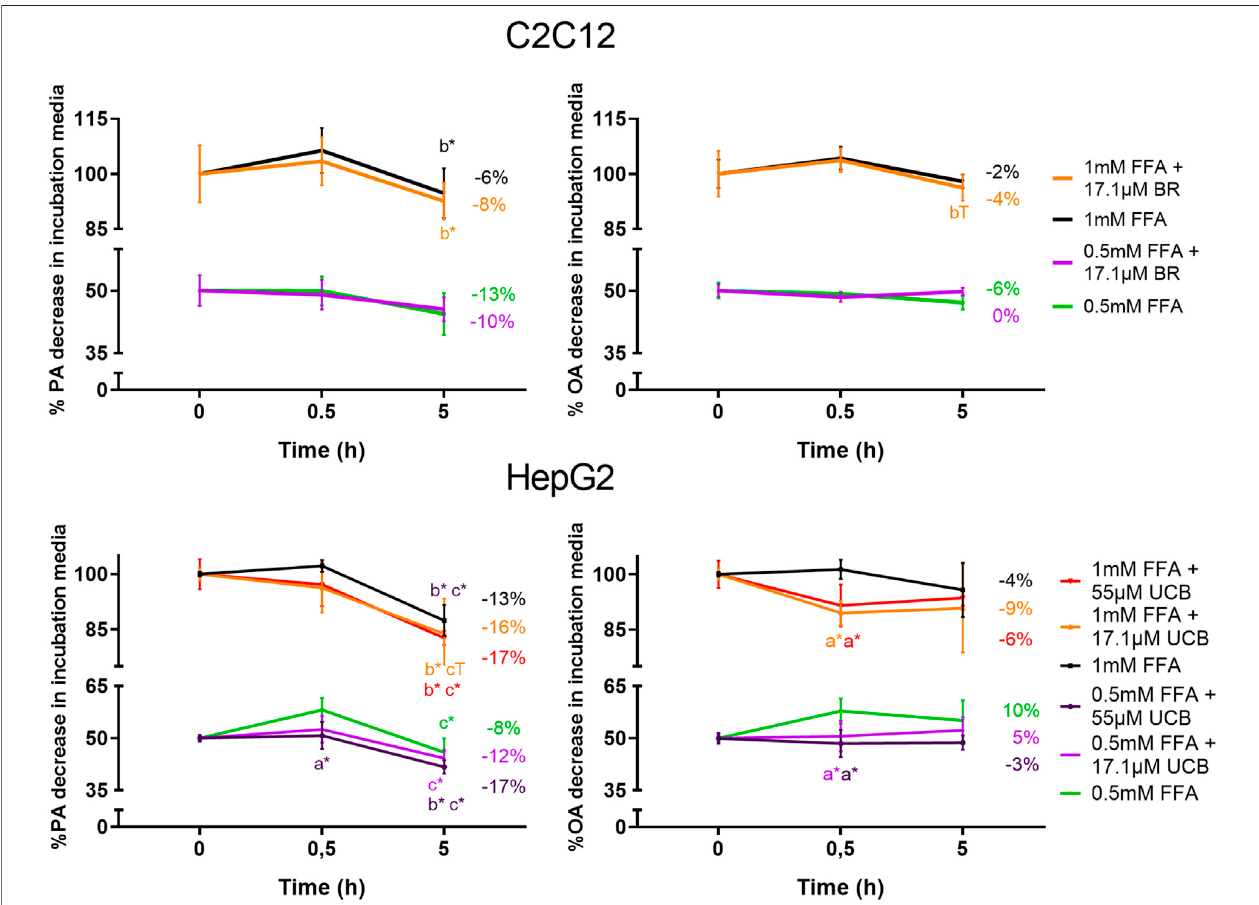
FIGURE 9 | UCB slightly increased the FFA uptake of HepG2 cells and did not signi fi cantly change the FFA uptake of C2C12 cells. Cells were exposed to the respective treatments for 0.5 and 5 h at hypoglycaemic conditions. The FFA uptake was assessed indirectly by measuring the PA and OA concentrations in the supernatant ofboth celllines by gaschromatography.Dataaremean ± SDofn (cid:2) 3(each intriplicate).* p ≤ 0.05, T p ≤ 0.1of a (cid:2) compared toUCB treated vs. untreated cells, of b (cid:2) compared to the preceding incubation time and of c (cid:2) compared to the initial concentration of the incubation media.